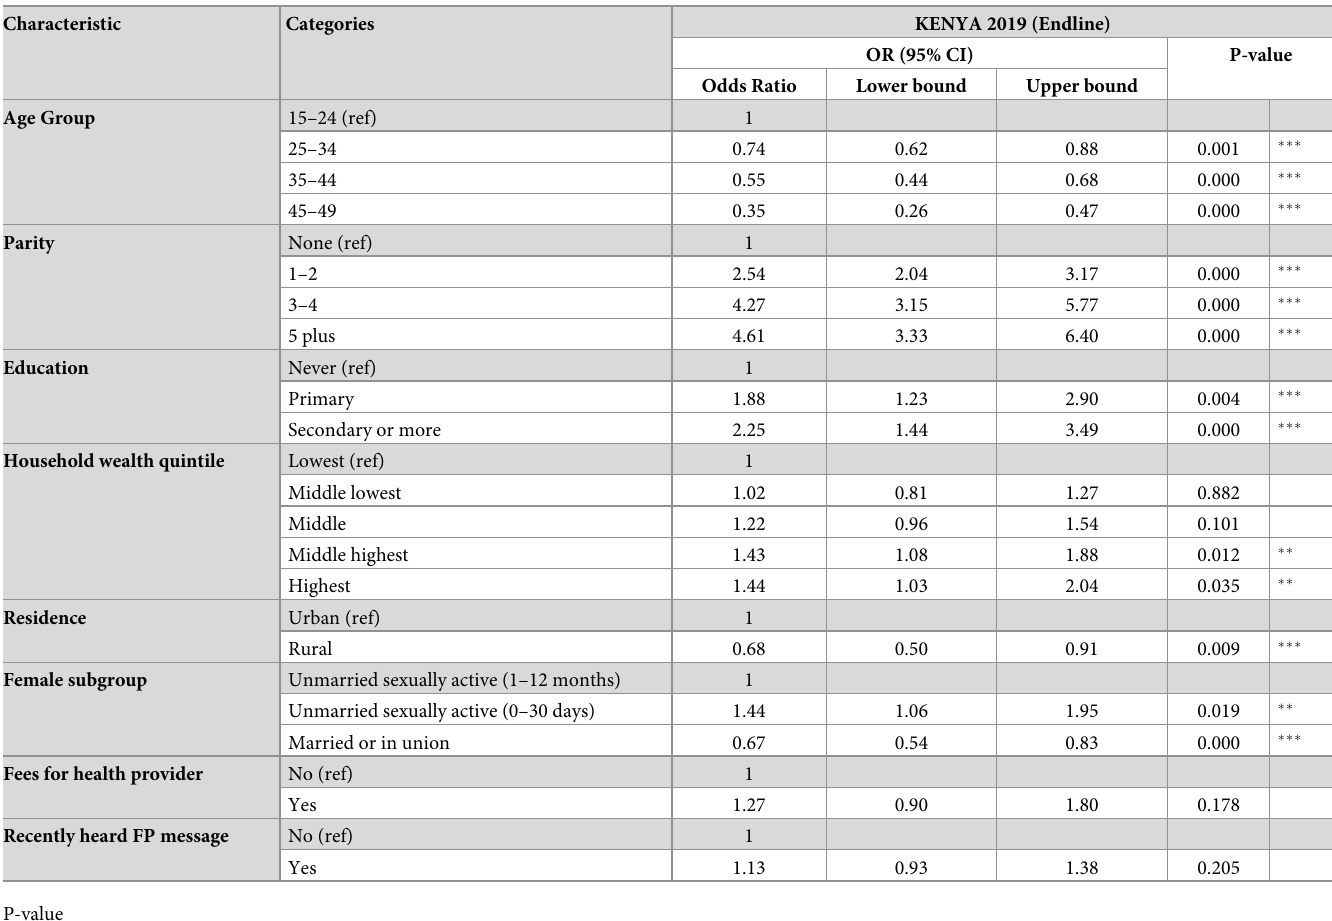
Table 5. Logistic regression model for mCPR at last sexual intercourse, PMA/Kenya 2019.